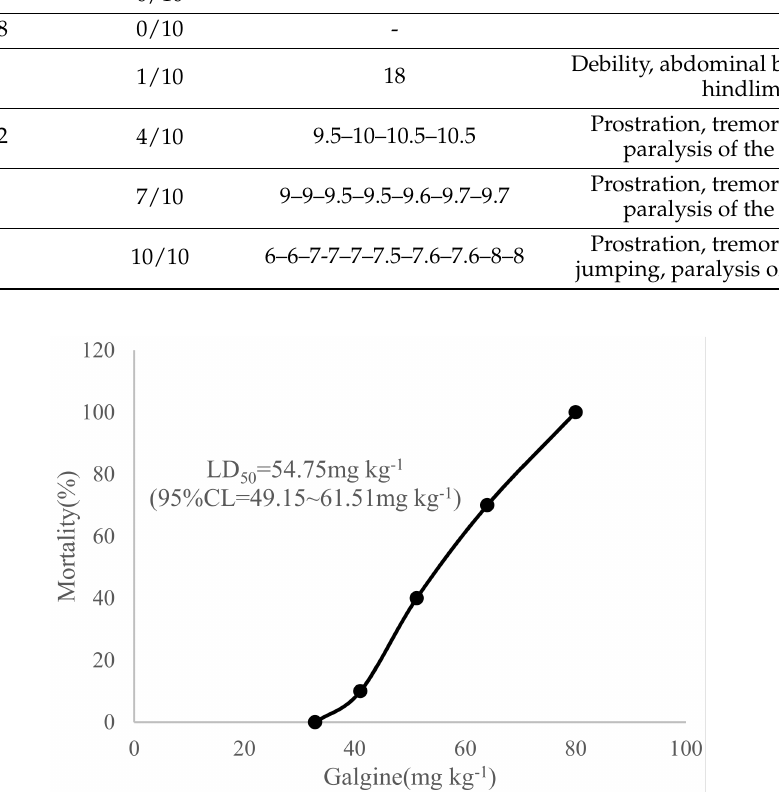
Figure 3. Dose-response mortality curve of galegine after i.p. injections administration in mice. Percentage lethality is plotted against the administered doses of